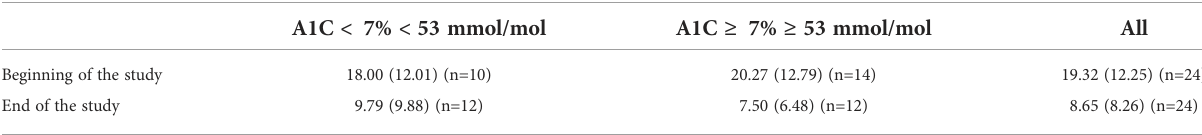
TABLE 4 Post – hoc comparison of average PAID Problem Areas in Diabetes Scale among children and adolescents with A1C < 7% (< 53 mmol/ mol) versus children and adolescents with A1C ≥ 7% ( ≥ 53 mmol/mol). PAID Problem Areas in Diabetes ScaleMean